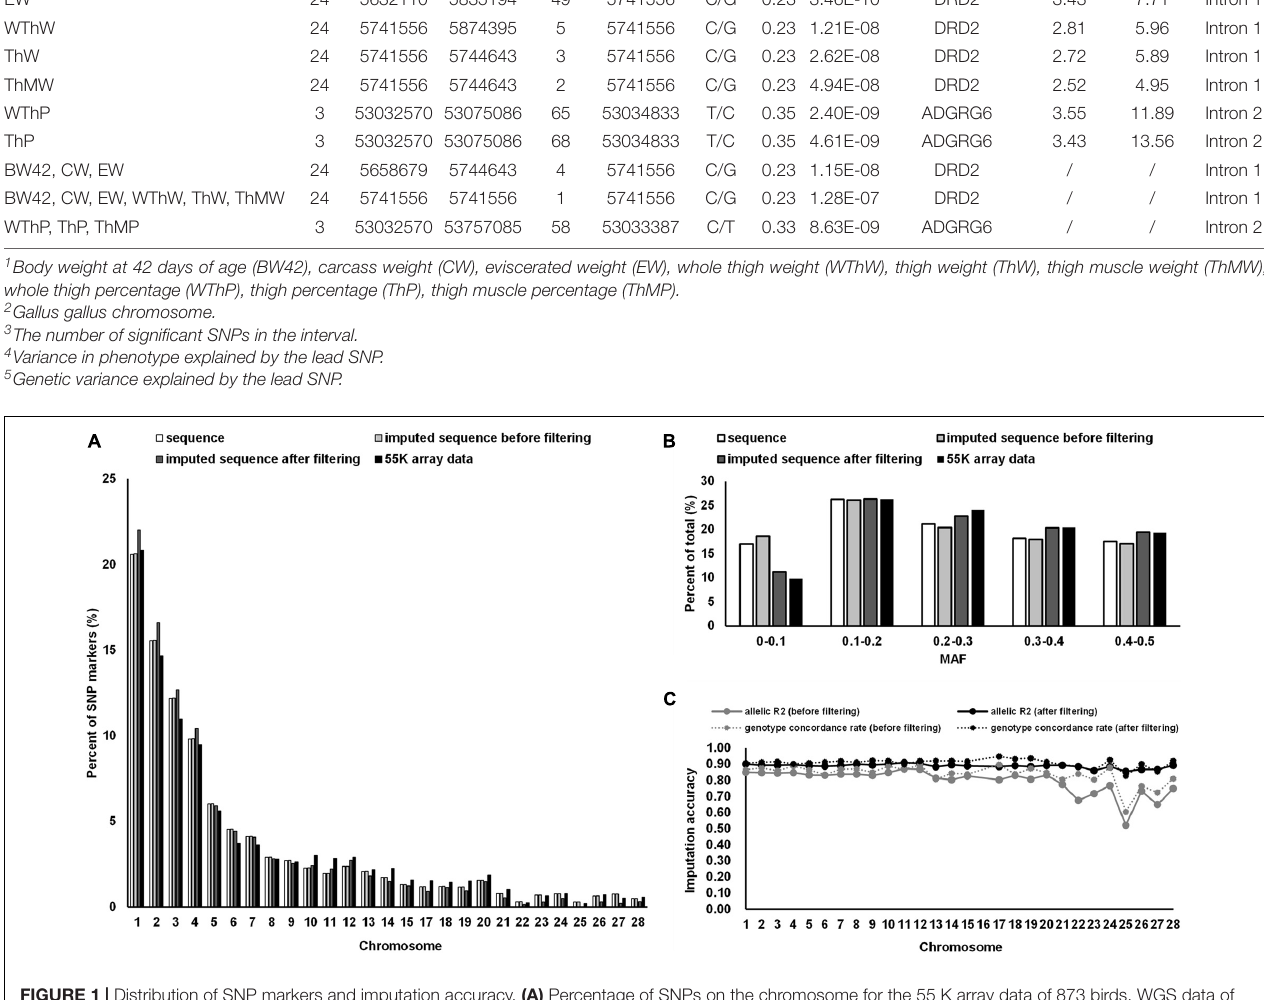
to homozygotes, whereas heterozygotes had intermediate